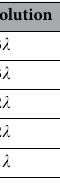
Table 1. Resolution obtained by different